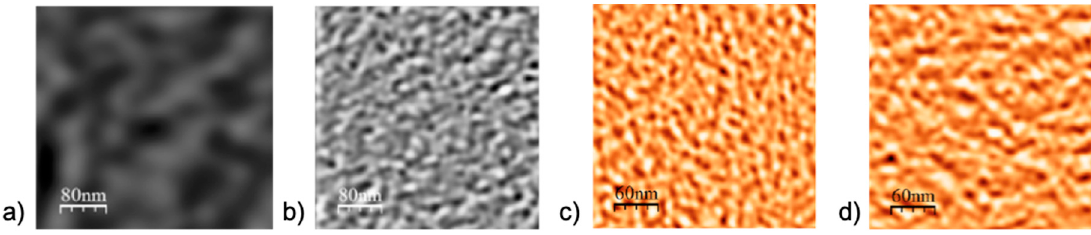
Figure 7. Height ( a ) and phase contrast ( b – d ) AFM images recorded in tapping mode of EB-cured epoxy diacrylate (EPAC) samples at conversion levels x = 0.41 ( a , b ), 0.46 ( c ), and 0.59 ( d ).